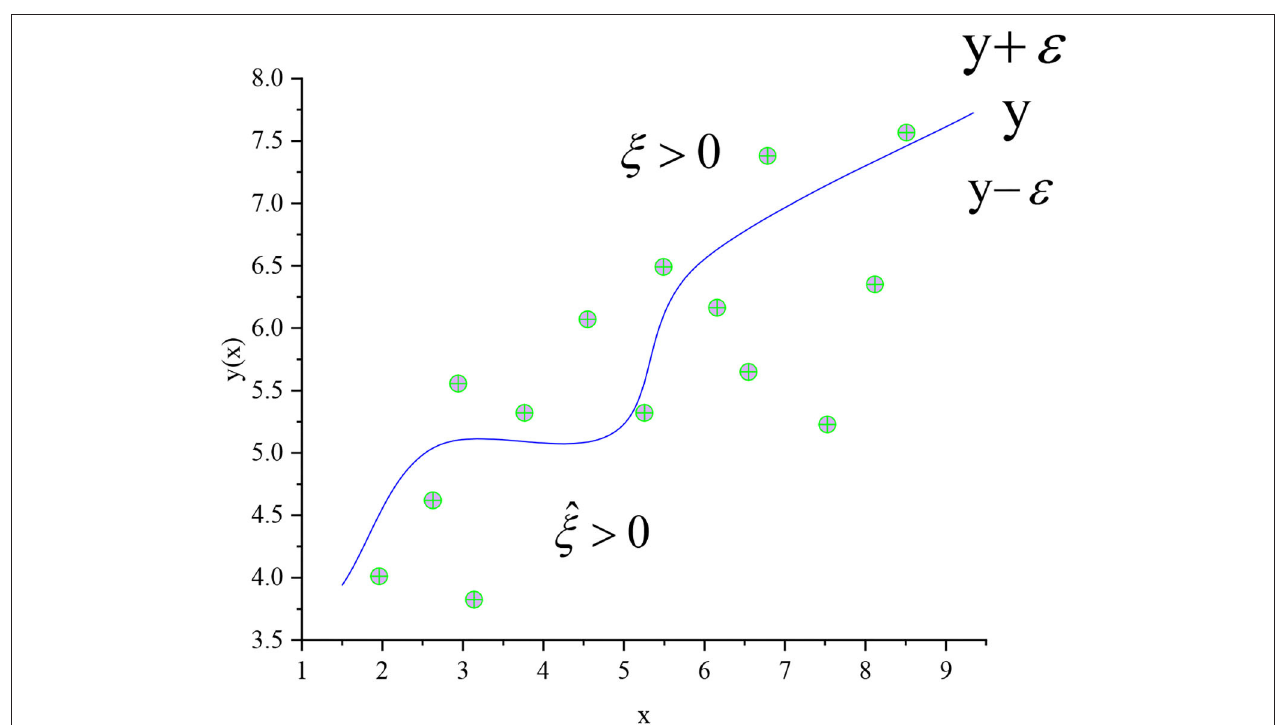
FIGURE 4 | Regression curve of